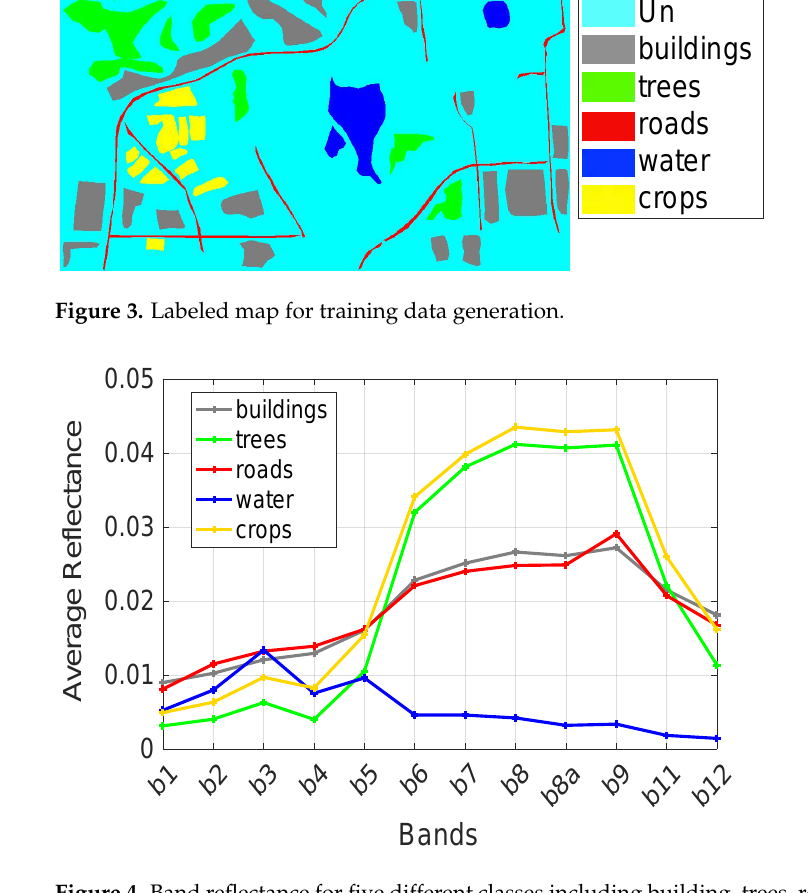
Figure 4. Band reflectance for five different classes including building, trees, roads, water, and